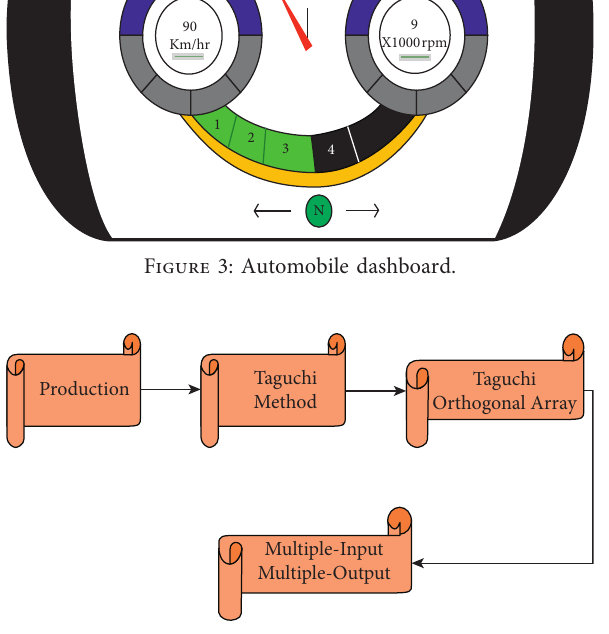
Figure 4: Optimization plan. Table 3: Signal-to-noise ratio of shrinkage volume and warping